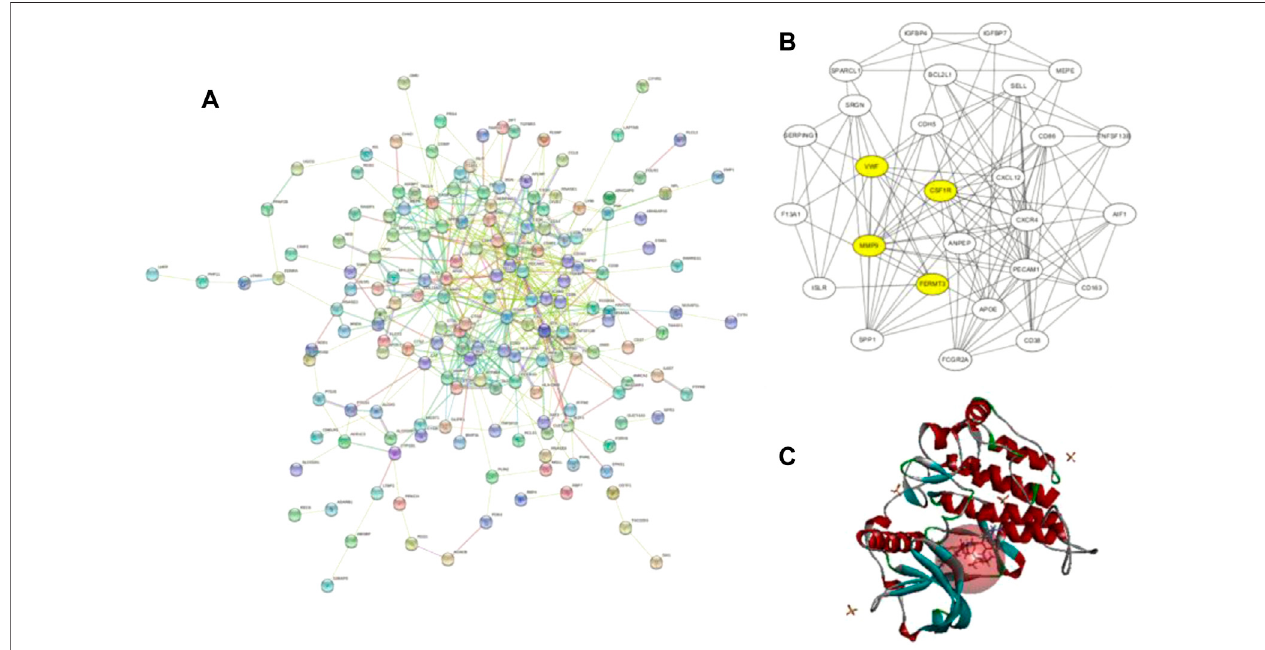
FIGURE 3 | (A) Protein – protein interaction network of upregulated genes from the STRING database; (B) this interaction network is the core network from (A) , which was calculated in Cytoscape. The four yellow core HUB proteins were obtained by comprehensive analysis with KEGG and GO; (C) binding diagram of ZINC150338698 to protein 6T2W, and the red ball is the binding